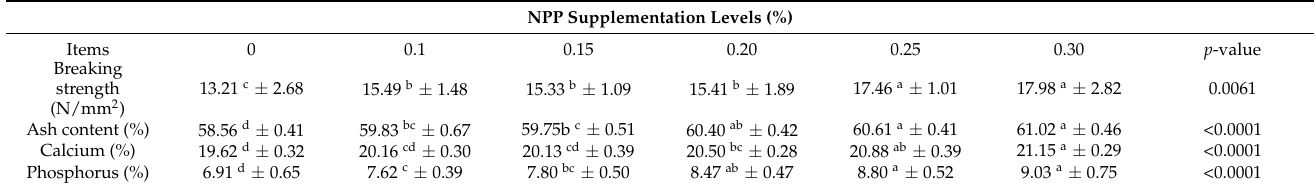
Table 5. Effect of the level of dietary NPP supplementation on tibial quality of Hy-Line Brown laying hens (69–78 weeks of age) fed a phytase-containing diet 1,2,3 .